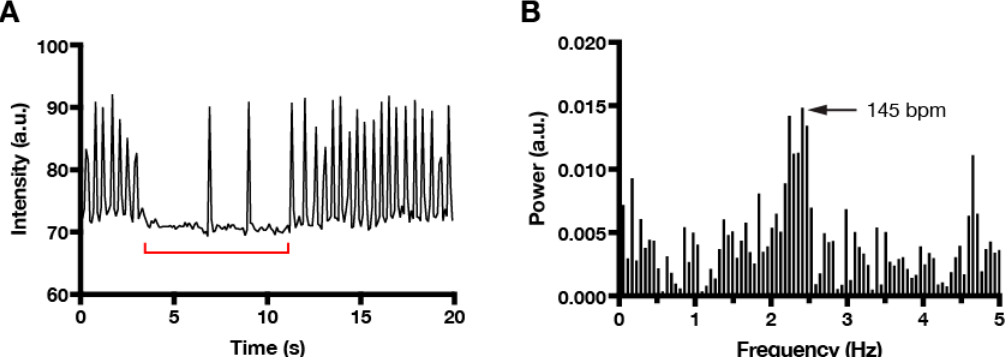
Figure 3. FFT analysis correctly identifies dominant frequencies despite pauses in beating. ( A ) Time series plot showing intermittent pauses (red bracket) in fast beating. ( B ) FFT plot reveals a single dominant beating frequency (145 bpm) that is approximately double the value calculated manually by averaging the number of spikes over time (~84 bpm).